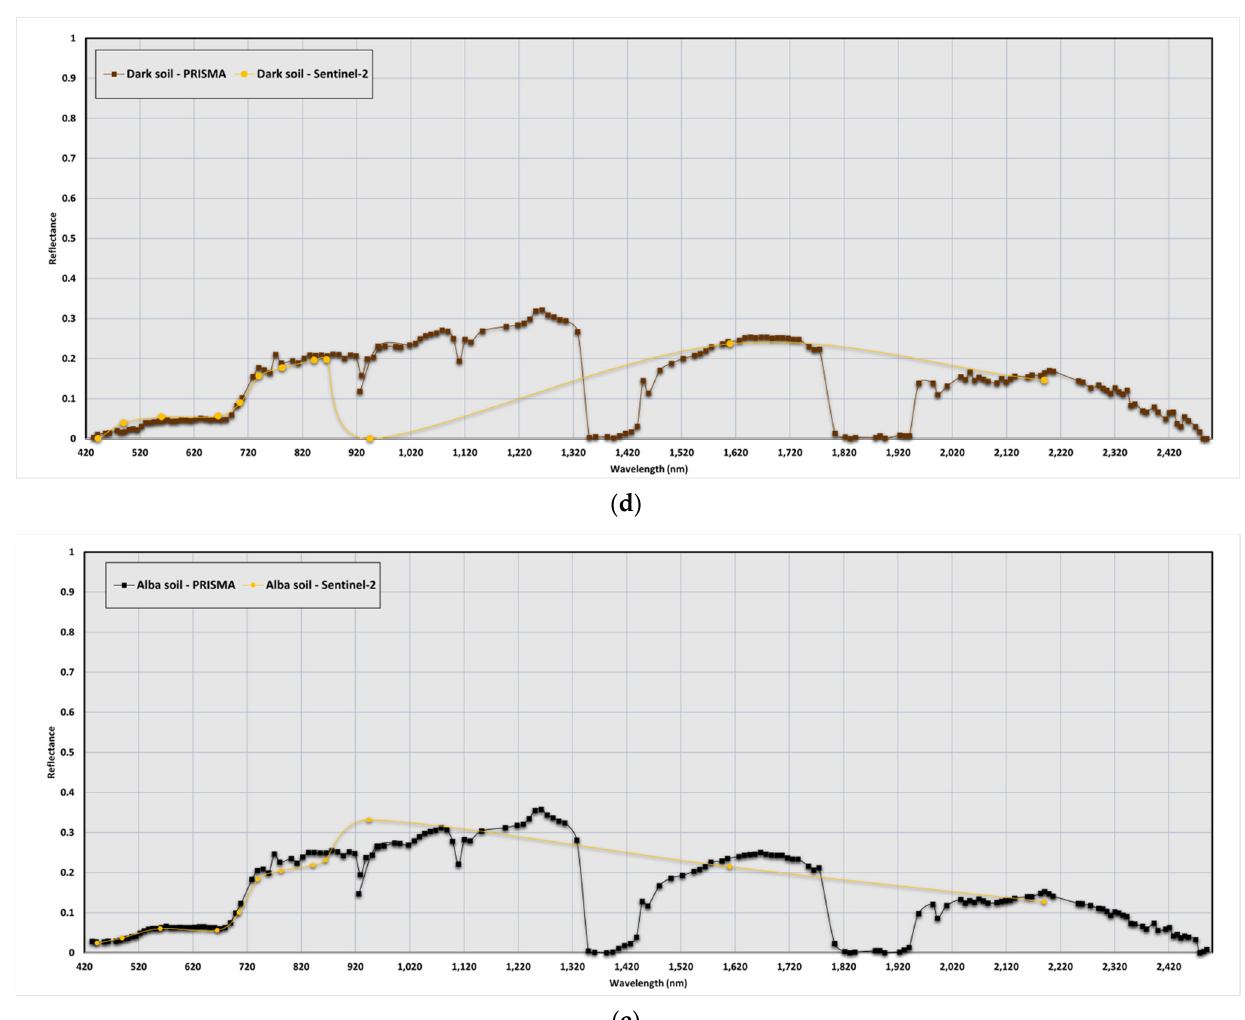
Figure 15. Alba Fucens’ PRISMA and Sentinel ‐ 2 spectral signatures comparison: ( a ) pits, ( b ) rocks; ( c ) light soil, ( d ) dark soil, ( e ) archaeological site soil. At 443 nm and 945 nm Sentinel ‐ 2 has “Not A Number” for light and dark soils.